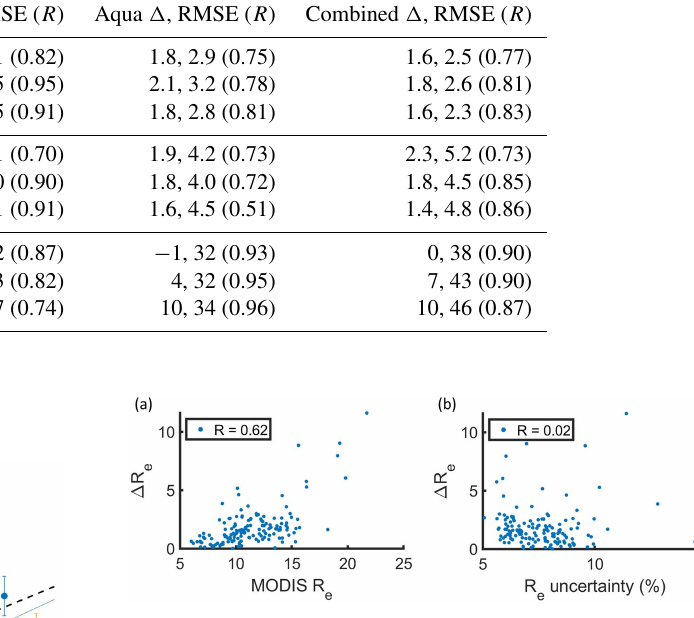
Figure 4. Magnitude of the difference between MODIS R e and in situ R e ( (cid:49)R e ) for profiles with a MODIS retrieval co-located with in situ data for (cid:49)T less than 3600s as functions of (a) MODIS R e and (b) MODIS R e uncertainty. Each point represents the average over a 5 × 5 pixel domain.